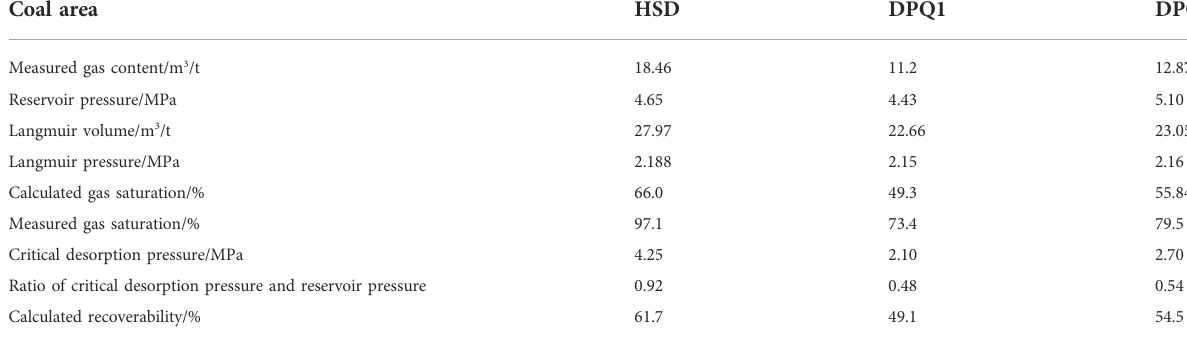
TABLE 2 Recoverability evaluations for mining areas of Hongshandian and Duanpoqiao.